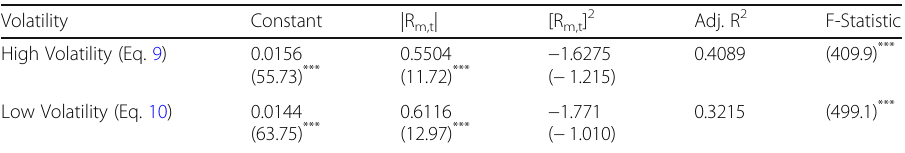
Table 5 Herding behavior during high and low market volataity Volatility Constant |R m,t | [R m,t ] 2 Adj. R 2 F-Statistic High Volatility (Eq. 9) 0.0156 (55.73) *** Low Volatility (Eq.